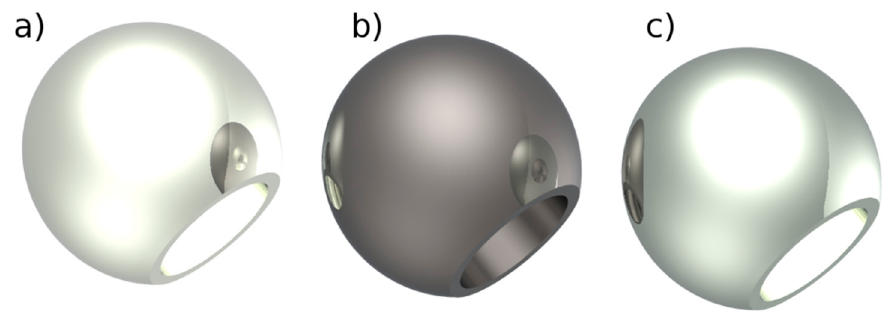
Figure 4. Metal femoral heads: ( a ) stainless-steel; ( b ) Oxinium; ( c ) CoCrMo.